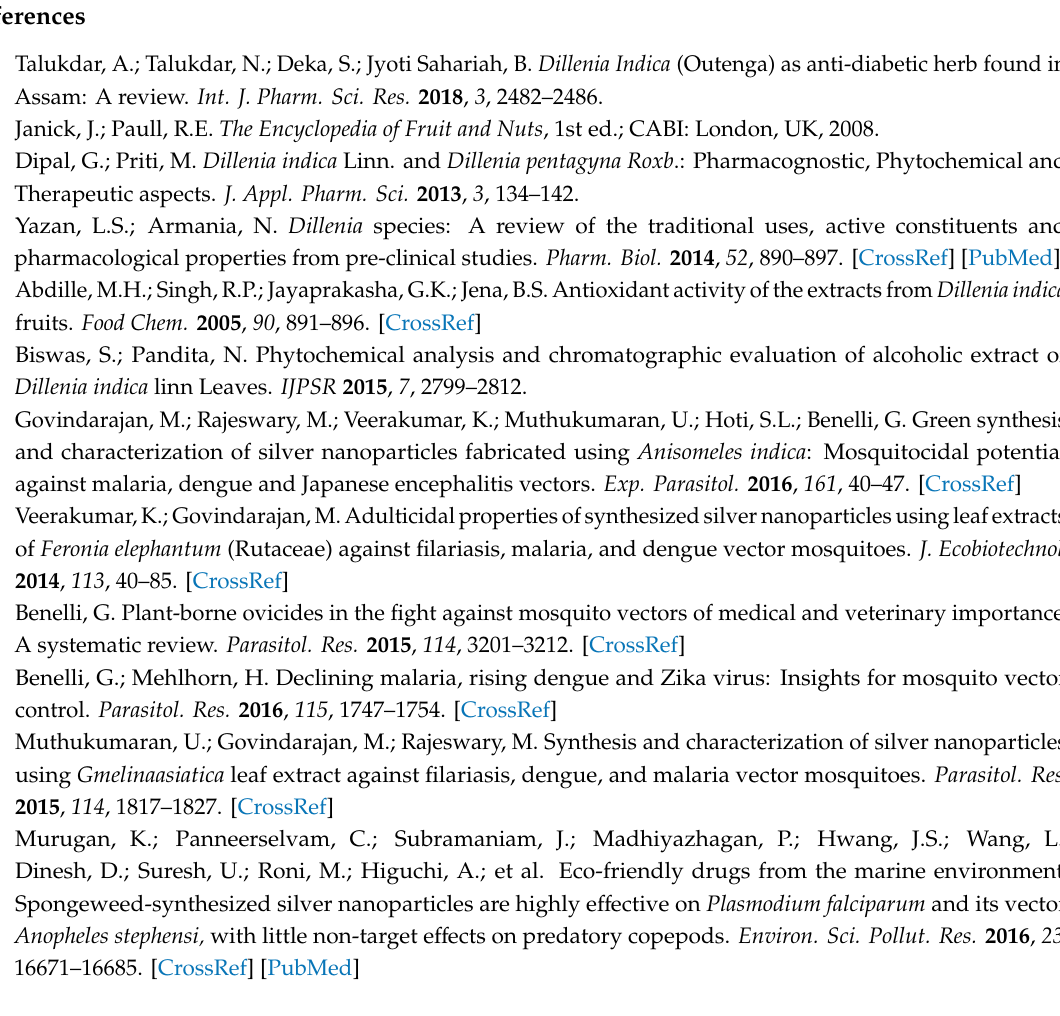
Table S1: E ff ect of Selenium Nanoparticles on developmental stages of Aedes aegypti at 24 h exposure. Table S2: E ff ect of Selenium Nanoparticles on developmental stages of C. quinquefasciatus at 24 h exposure. Table S3: Antibacterial e ff ect of Selenium nanoparticles against Staphylococcus aureus and Serratia